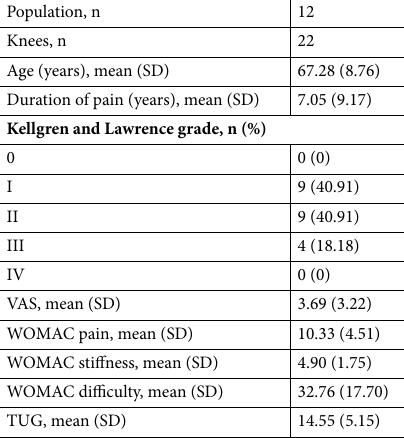
Table 2. Clinical and radiographic data of knees with no USG finding. USG ultrasonography, n number, % percentage, SD standard deviation, VAS visual analogue scale, WOMAC Western Ontario and McMaster Universities Osteoarthritis Index, TUG timed up and go